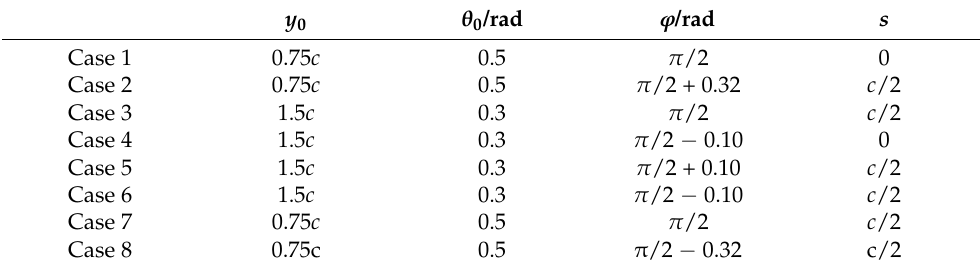
Table 1. Definition of eight working conditions with different phase difference and pivot position. y 0 θ 0 /rad ϕ